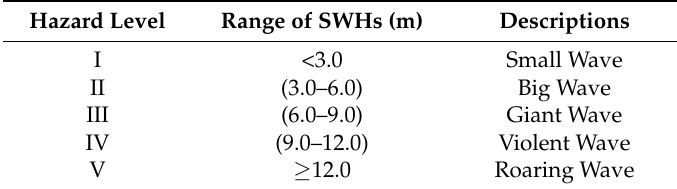
The classification of hazard levels corresponding to the ranges of significant wave heights (SWHs).